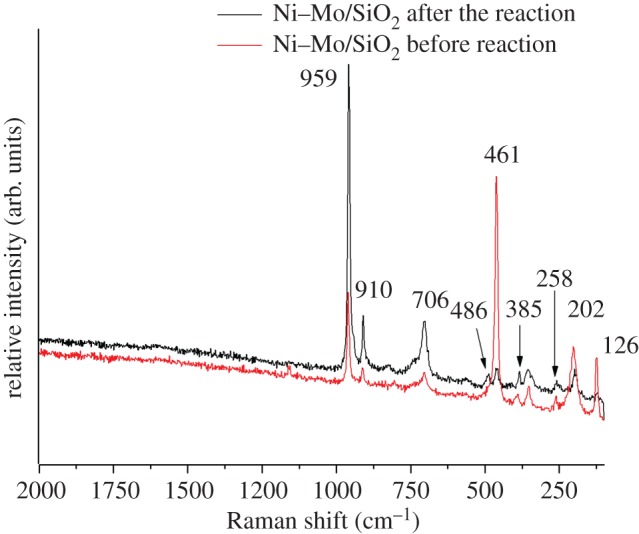
Raman spectra of the NiOx–MoOy/SiO2 catalyst in the second stage.